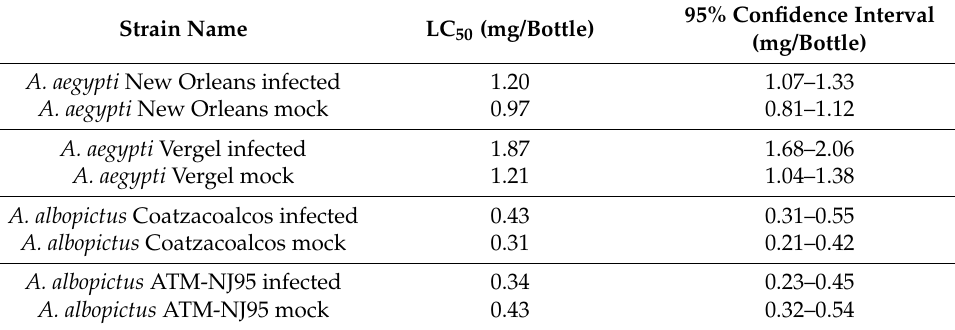
Table 3. Summary of nootkatone LC 50 s and corresponding confidence intervals (CI) among the four Aedes strains when ZIKV-infected or